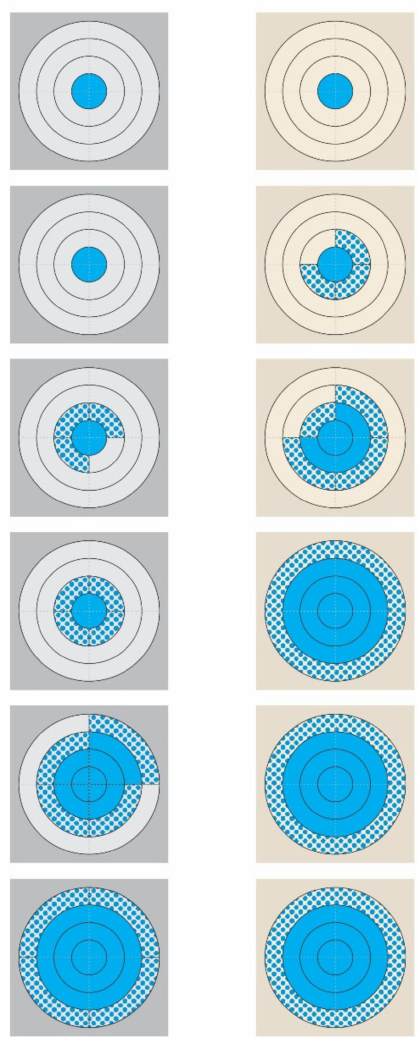
Figure 2. Diagrammatic presentation of the progressive growth of S. epidermidis from two polar chart-type complexes on pieces of teatcup material. (Legend: from top to bottom: 3 h, 6 h, 9 h, 12 h, 15 h, and 18 h post-smearing; ( left ): grey-coloured complex, cattle teatcup; ( right ): cream-coloured complex, sheep teatcup; blue motif pattern: the presence of S. epidermidis on a quadrant, blue full pattern: the coverage of a quadrant with S. epidermidis.